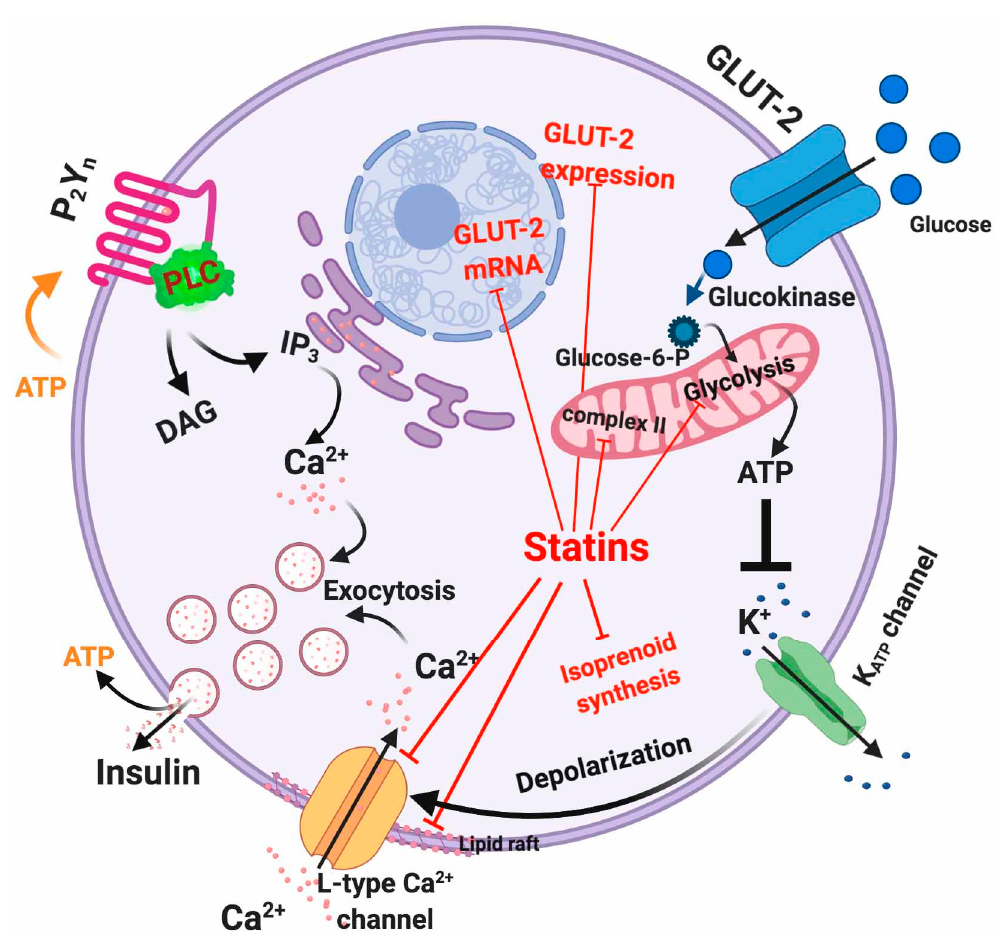
Figure 3. Intracellular actions of statins in β -cells. Red lines indicate the mechanisms affected by statins.